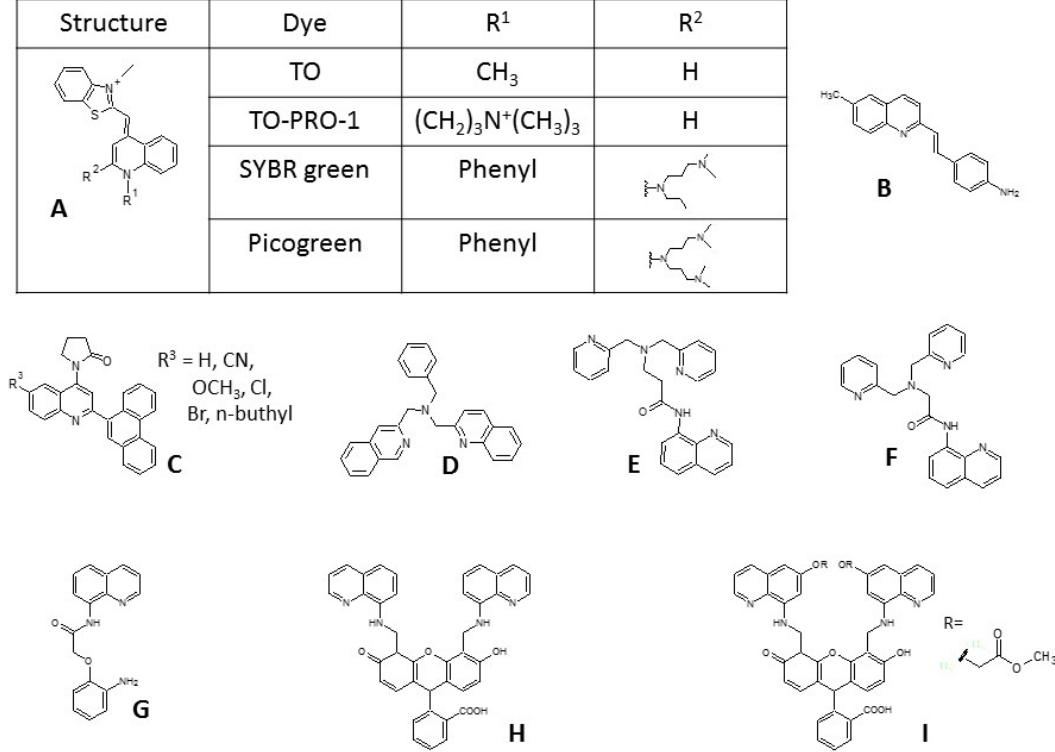
Figure 1. Examples of quinoline-based fluorophores and sensors. ( A ) carbocyanine dyes for DNA and RNA; ( B ) styrylquinoline for amyloid plaques; ( C ) quinoline dyes for bacterial application; ( D ) bisquinoline dye for metal detection; ( E ) and ( F ) dipicolylamine derivatives of quinoline as chemosensing dyes; ( G ) 8-aminoquinoline dye for physiological fluorescent labeling of Zn 2 + ; ( H ) and ( I ) fluorescein based probes for Zn 2 + detection.